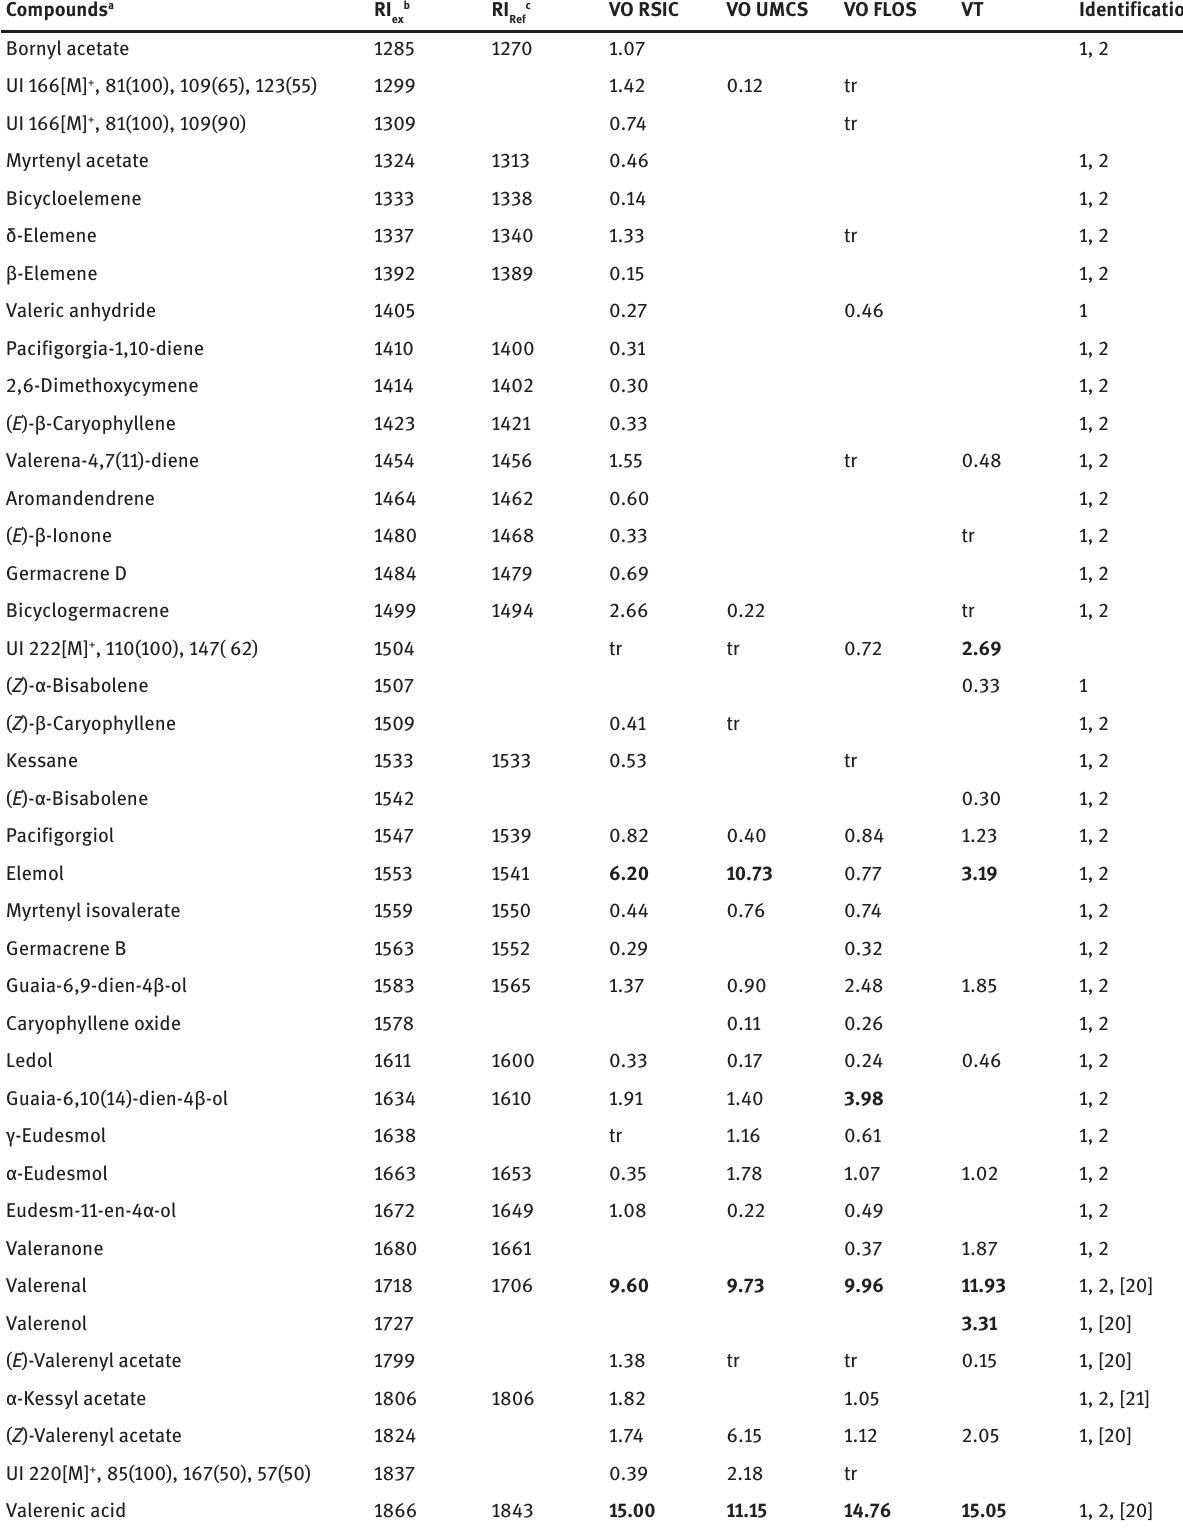
Table 1: Constituents (%) identified in the non-polar extracts of the underground parts of Valeriana samples analysed by GC/MS (boldface designates the principal